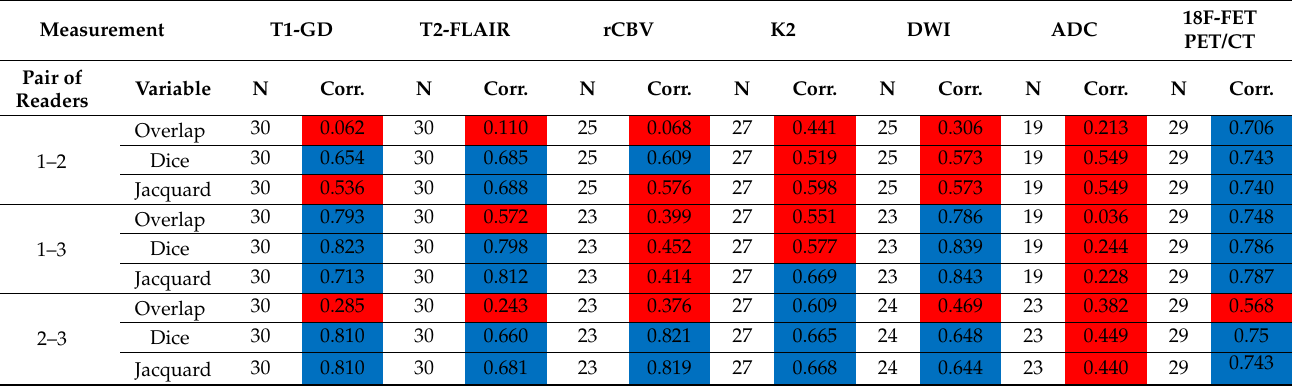
Table 3. The correlations between the different pairs of readers for DCS, JSC, and overlap for each sequence. Spearman’s correlation coefficient.